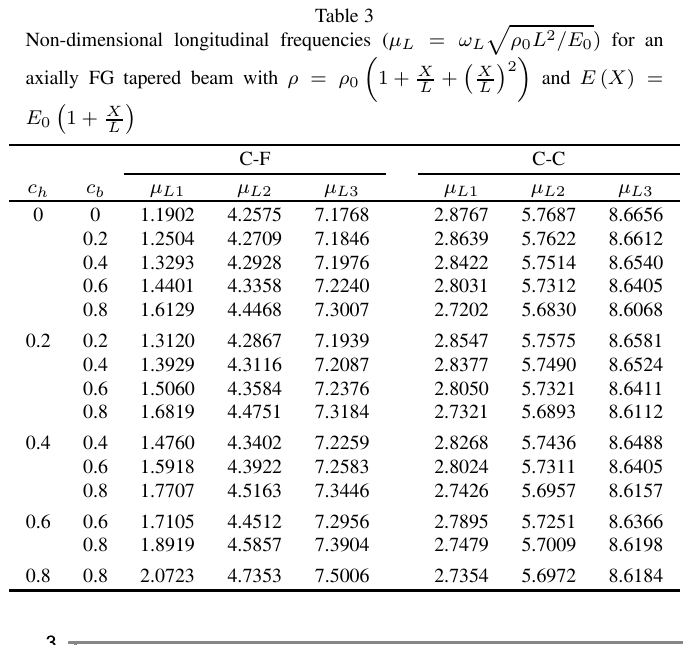
(cid:27) Table 3 ρ 0 L 2 /E 0 ) for an